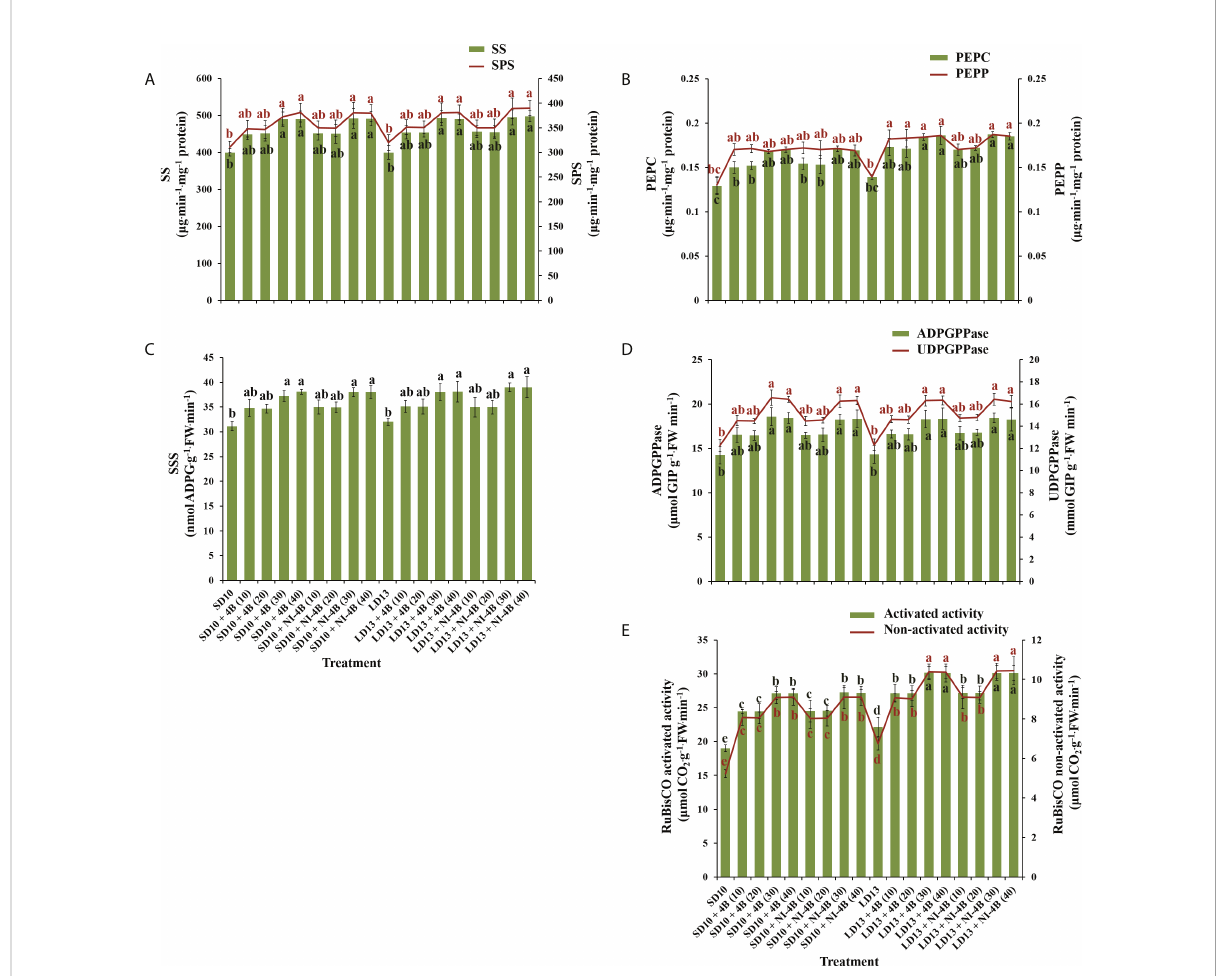
FIGURE 6 The effects on the enzymatic activities of chrysanthemum ‘ Gaya Glory ’ under different intensities of supplemental or night-interruptional blue light, after 60 days of exposure to the photoperiodic light treatments. Sucrose synthesis enzymes: (A) sucrose synthase (SS) and sucrose phosphate synthase (SPS), (B) phosphoenolpyruvate carboxykinase (PEPC) and phosphoenolpyruvate phosphatase (PEPP). Starch synthesis enzymes: (C) soluble starch synthase (SSS), (D) adenosine diphosphate glucose pyro-phosphorylase (ADPGPPase) and uridine diphosphate glucose pyro-phosphorylase (UDGPPase). And photosynthesis-related enzyme: (E) the activated or non-activated activity of Ribulose 1,5- diphosphate carboxylase/oxygenase (RuBisCO). Vertical bars indicate the means ± standard error (n = 6). Different lowercase letters indicate signi fi cant separation within treatments by Duncan ’ s multiple range test at p ≤ 0.05. See Figure 1 for details of photoperiodic light treatments with blue